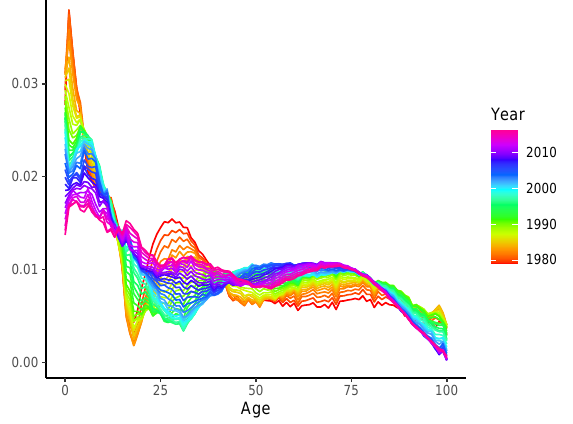
Figure 2. Dynamic age-specific declines ˆ b x , t